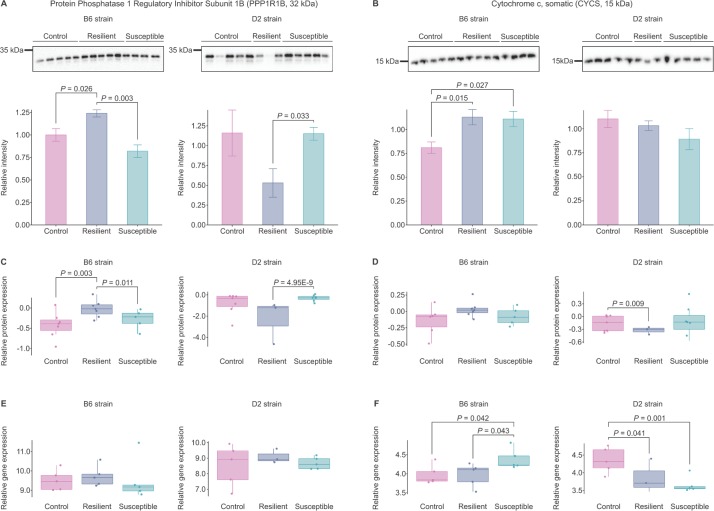
Protein phosphatase 1 Regulatory Subunit 1B (PPP1R1B) and cytochrome c somatic (CYCS) show opposite patterns of expression in the BNST of B6 and D2 strains following CSDS.(A-B) Western blot (WB), (C-D) relative protein (data set B; LC-MS/MS), and (E-F) gene expression (data set A; RNA sequencing) analysis of total PPP1R1B and CYCS in mouse BNST following exposure to CSDS. Mean values ± S.E.M. B6: C57BL/6NCrl; D2: DBA/2NCrl; LC-MS/MS: liquid chromatography–tandem mass spectrometry.